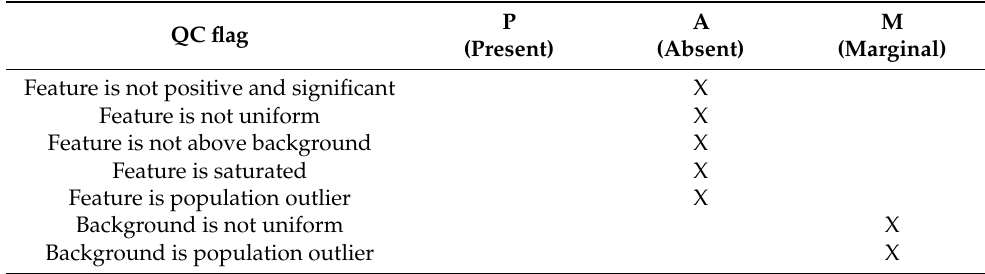
Table 2. CircRNA probe signal QC